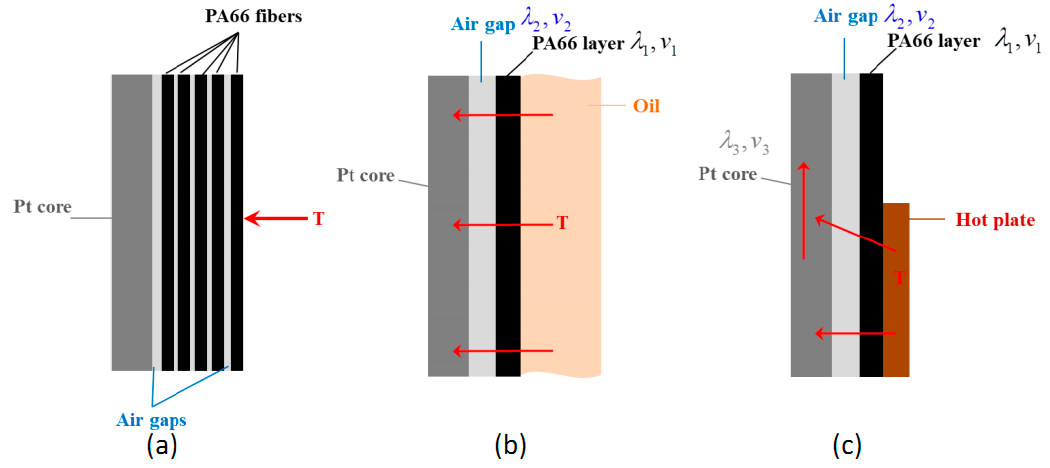
Figure 8. Ideal serial heat-transfer models. ( a ) Schematic heat transfer from outside to Pt core, accrossing fibers and air gaps; ( b ) Simplified model subjected to hot oil; ( c ) Simplified model heated by hotplate.